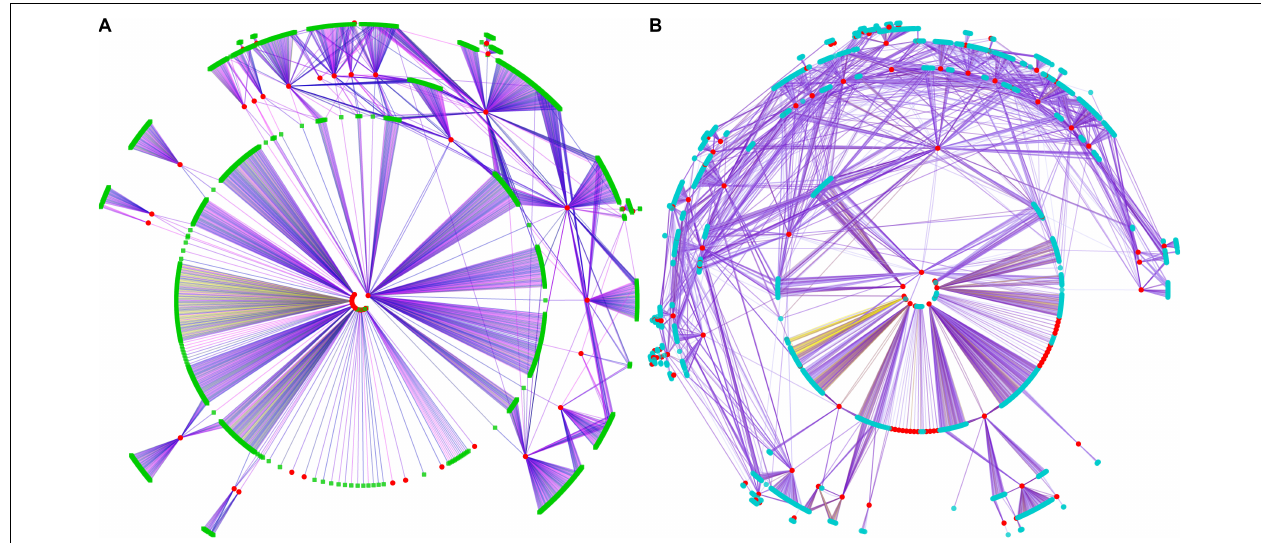
FIGURE 4 | Co-expression network of genes in selected regions of A54 and B154. Graphical view of the co-expression network where the nodes correspond to genes and the edges to co-expression links. Different colored edges represent interaction modules of different selection genes. (A) Co-expression network of selected genes of A54, and selected genes marked in red, interactive genes were marked in green. (B) Co-expression network of selected genes of B154, and selected genes marked in red, interactive genes were marked in blue.